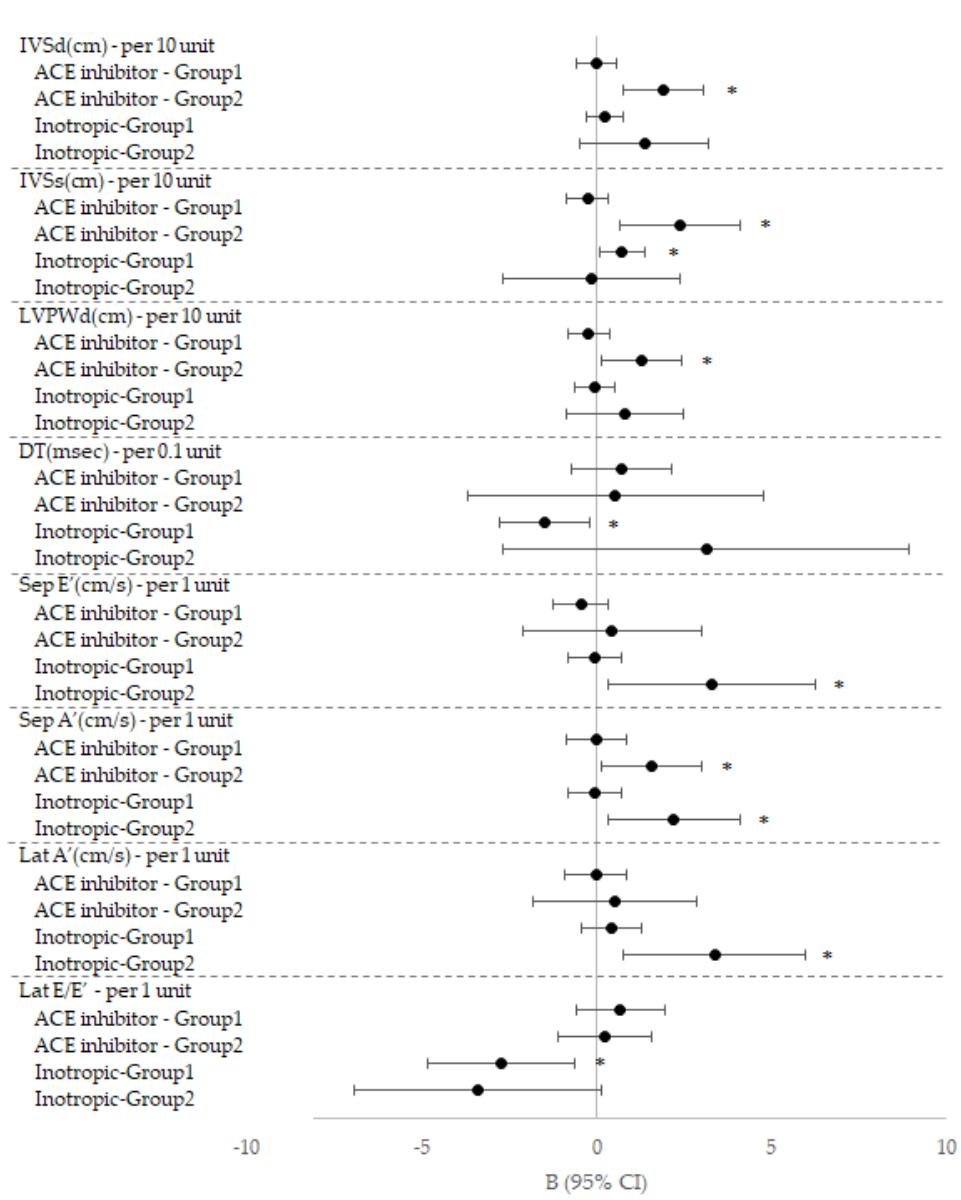
Figure 2. The e ff ect of ACE inhibitor and inotropic agents on echocardiographic measurements in each group. IVSd: Interventricular septal end diastole; IVSs: Interventricular septal end systole, LVIDd: Left ventricular internal diameter end diastole; LVIDs: Left ventricular internal diameter end systole; LVPWd: Left ventricular posterior wall end diastole; LVPWs: Left ventricular posterior wall end systole; EDV: End-diastolic volume; ESV: End-systolic volume; EF: Ejection fraction; SV: Stroke volume; FS: Fractional shortening; DT: Deceleration time; E: peak early inflow velocity; A: peak late inflow velocity; E’: peak early diastolic velocity; A’: peak late diastolic velocity; S’: peak systolic velocity; * : p -value < 0.05.